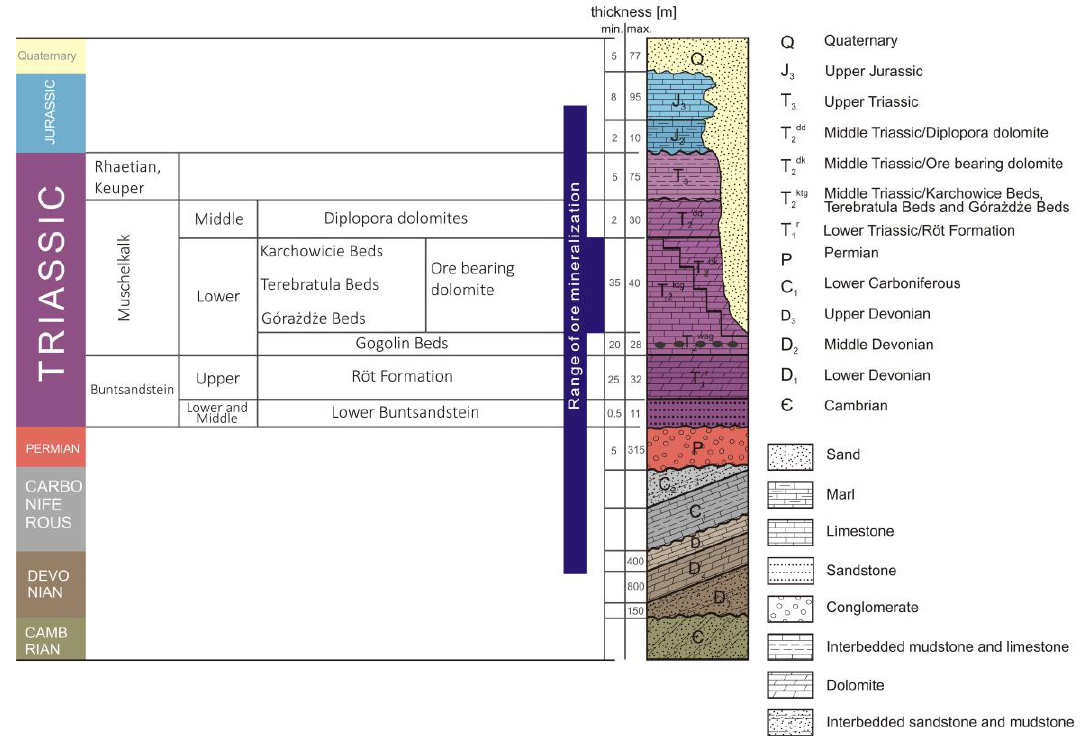
Figure 2. Schematic lithostratigraphic position of the Zn-Pb ore series within sedimentary rocks in the Silesia-Cracow district modified after [6].